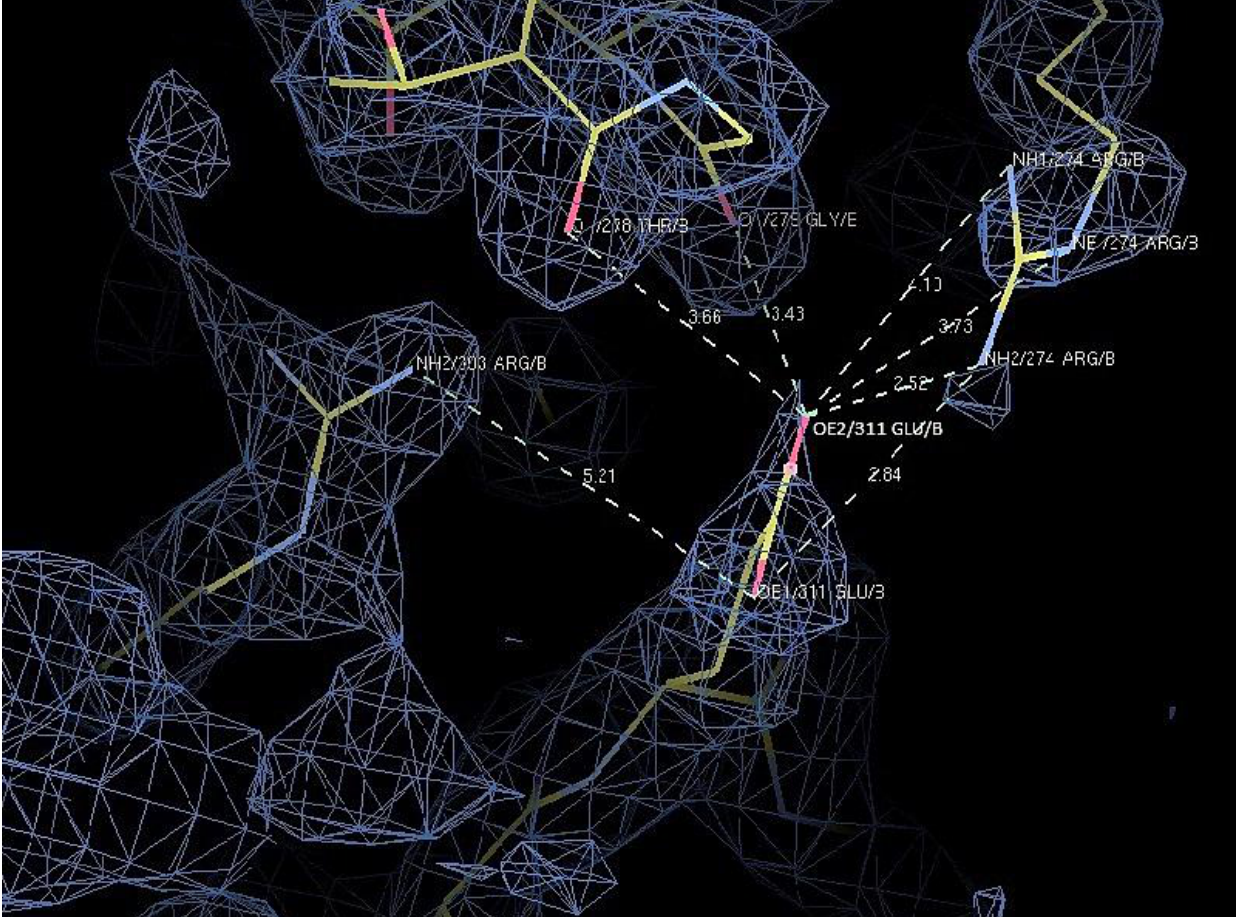
* The generated 2Fo-Fc electron-density maps with 1.0 sigma